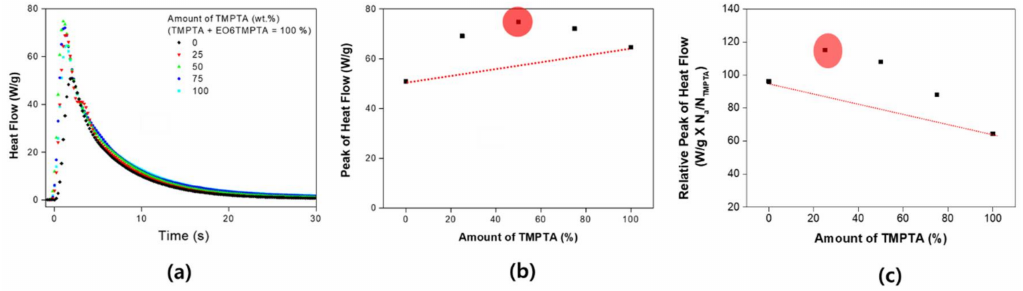
Figure 5. Heat flow of blending system: ( a ) real-time heat flow; ( b ) maximum heat flow of the binary monomer system (red circle: highest heat flow point); and ( c ) comparison of the relative value based on acrylate